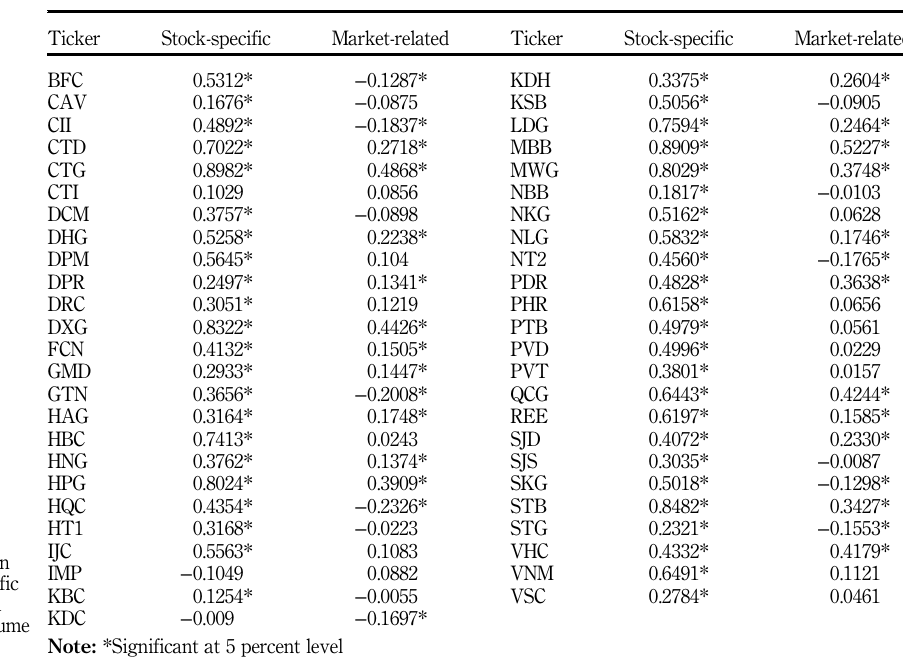
Fuller (ADF) test results of Ln(SVI), TPI and standard deviation of returns